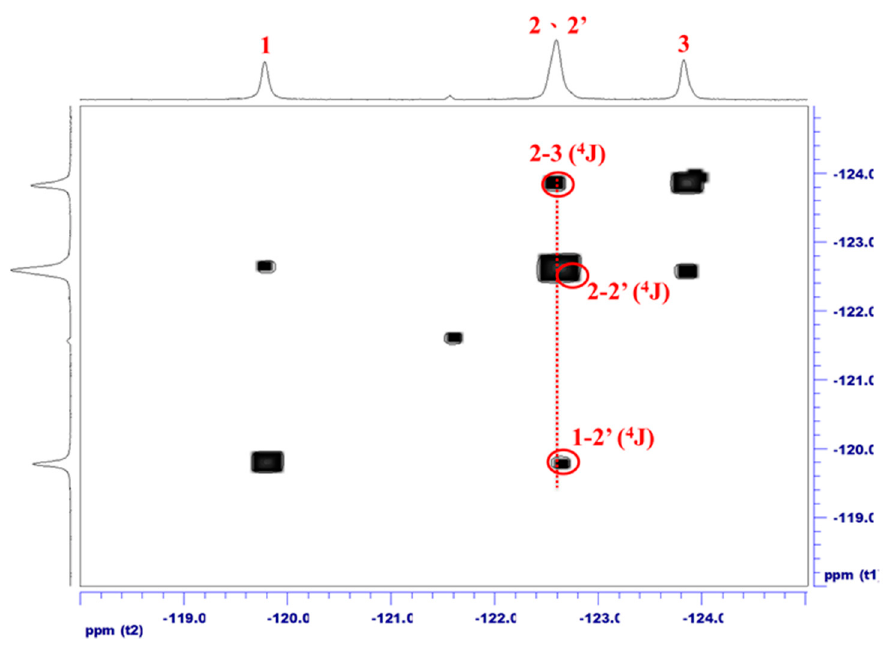
Figure 5. 19 F– 19 F COSY NMR spectrum of PFD/PU-03.